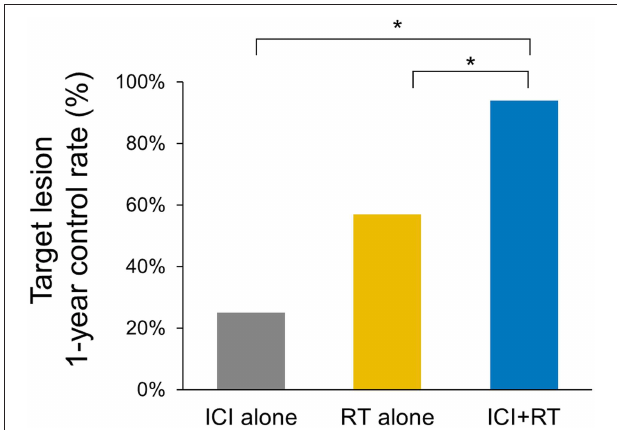
FIGURE 1 | Comparison of the 1-year local control rates of the target lesion in three treatment groups (ICI + RT vs. RT alone, 94.1% and 57.1%; p = 0.028, ICI + RT vs. ICI alone, 94.1% vs. 25%; p < 0.001). ICI, immune checkpoint inhibitors; RT, radiotherapy; ICI + RT, pembrolizumab combined with